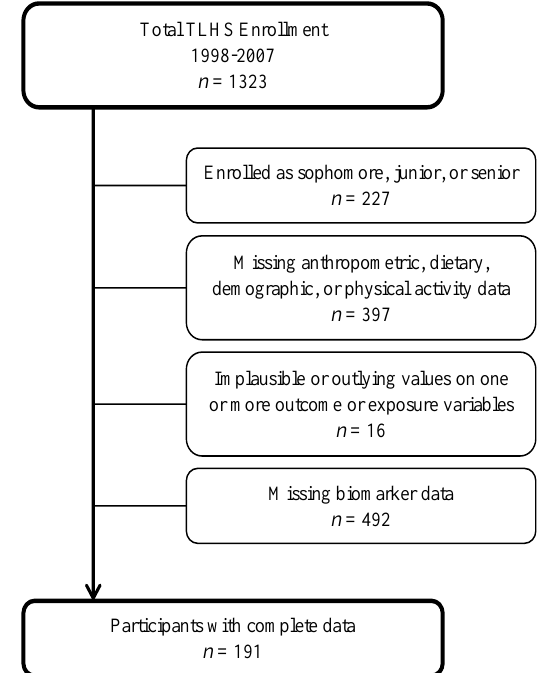
Figure 1. Flow chart depicting analytic sample deduction (boxes to the right indicate the number of participants excluded for each reason).